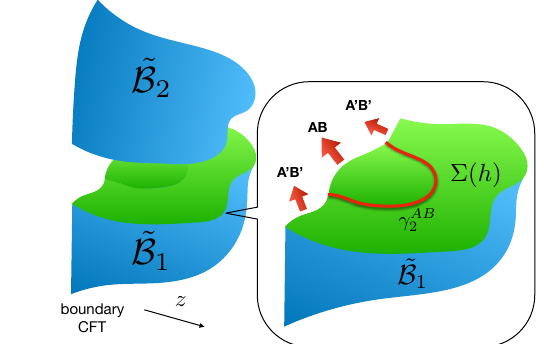
= (cid:26) AB (cid:26) AB . Left: Euclidean path-integral N h j i ~ under B 1 \ B 2 . Due to the brane backreaction, the bulk portions 2 2